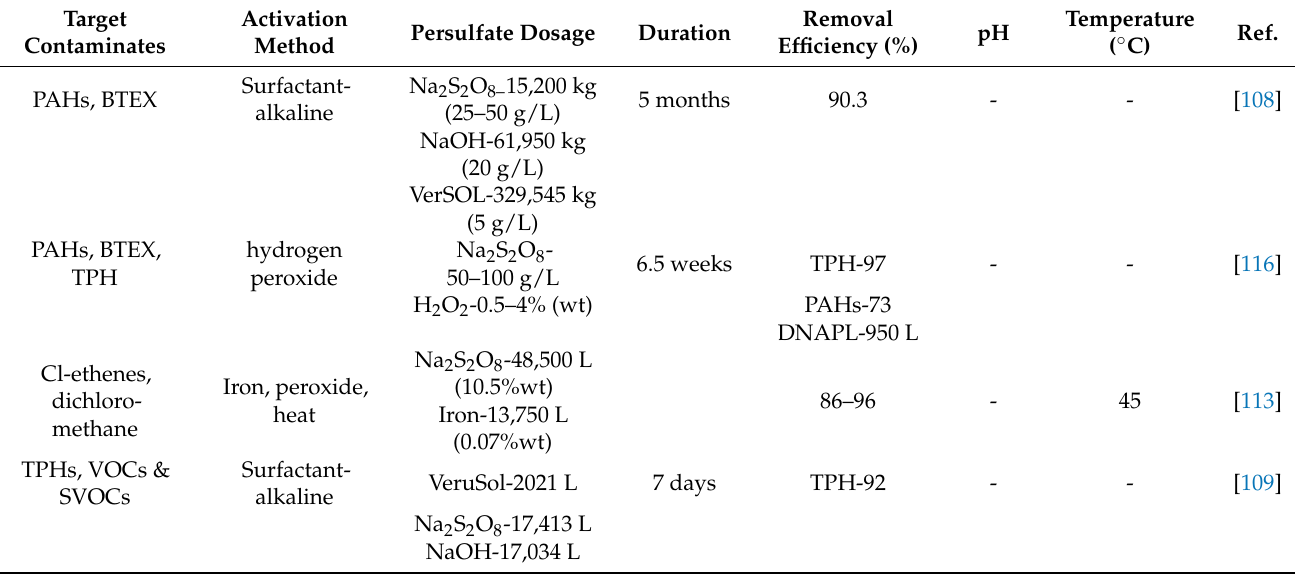
Table 5. Pilot scale and site applications with